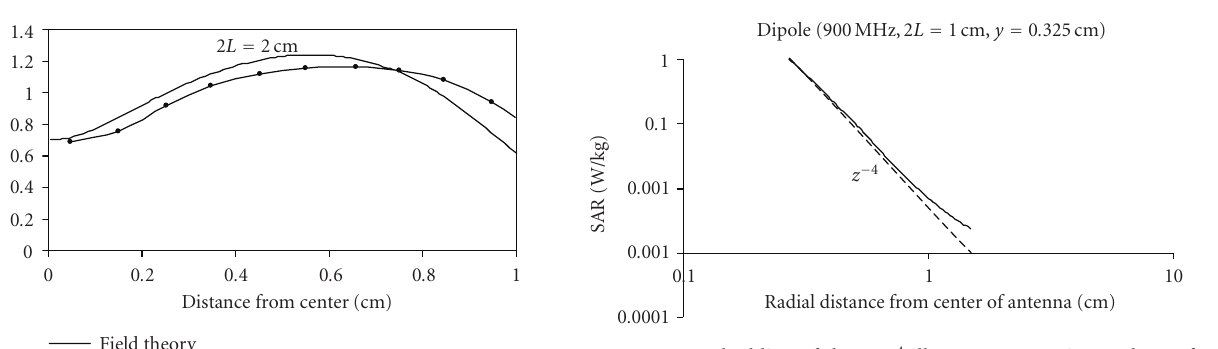
Figure 6: Dashed line of slope z − 4 illustrates approximate slope of the decay in SAR as function of depth into tissue for the 1 cm total length antenna.